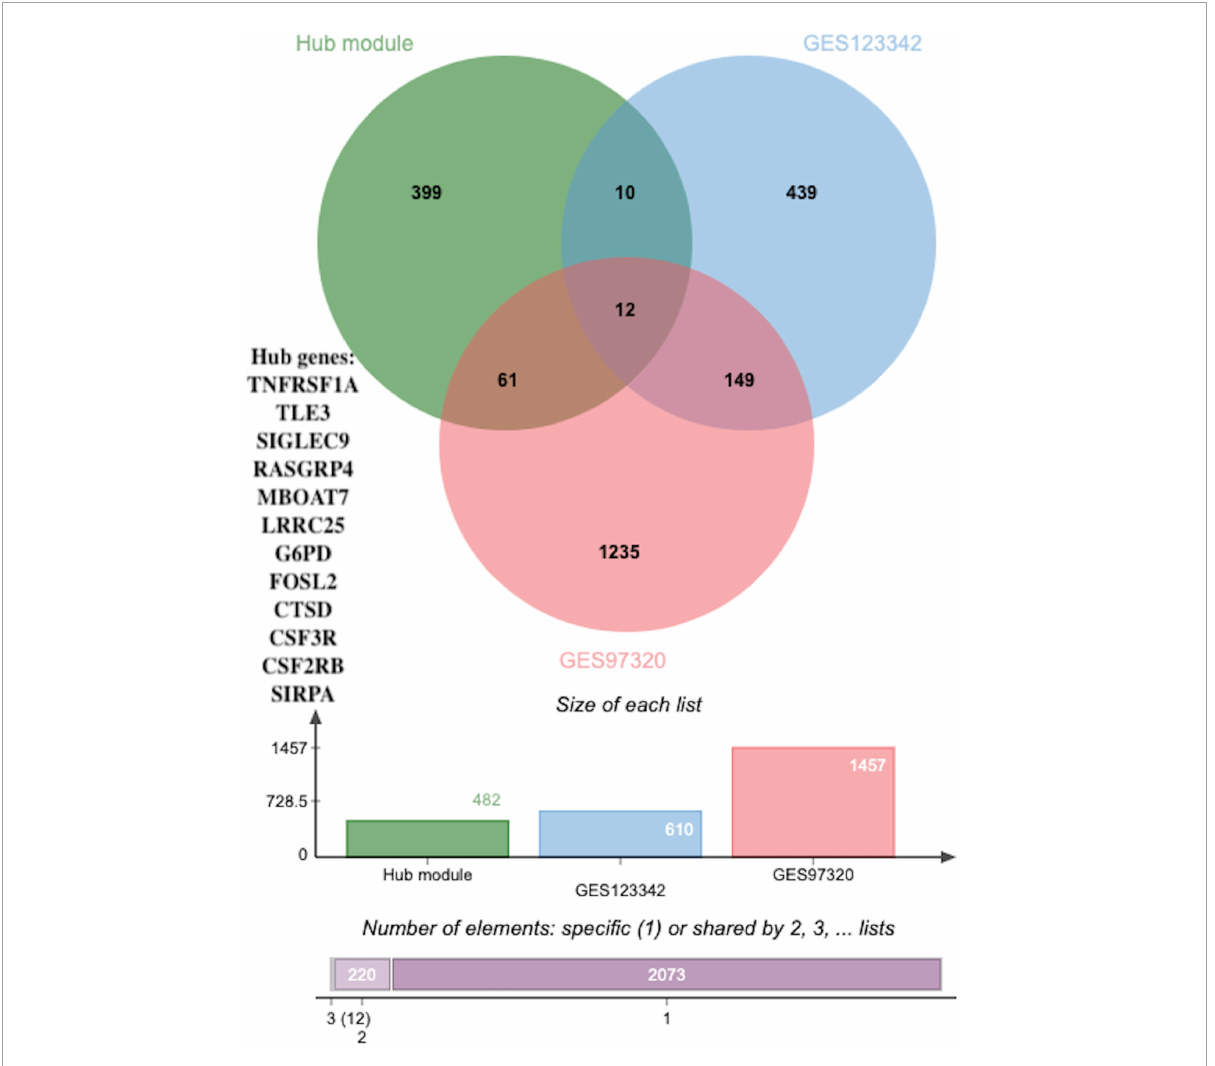
FIGURE7 The overlapped hub genes from different databases. Twelve overlapping genes were identified as potential key genes through using a Venn diagram between DEGs ( p < 0.05 and |log2FC| > 0.5) in GSE123342, DEGs ( p < 0.05 and |log2FC| > 0.5) in GSE97320 and hub